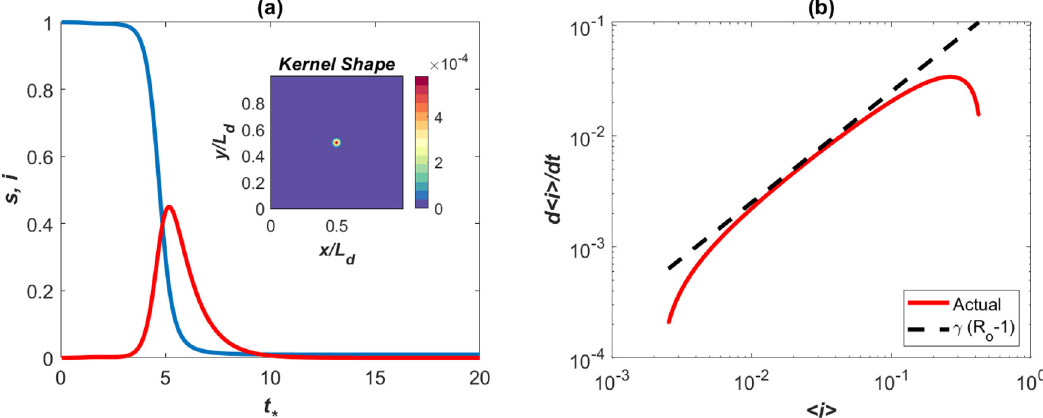
Fig 8. SIR model with super-spreaders: spatially integrated results. (a) Modeled < s ( t ) > and < i ( t ) > , where < . > is spatially integrated quantities (the inset shows the Gaussian spatial spread kernel). (b) The early times dynamics showing the effects of super- spreaders in the phase of d < i > / dt versus < i > . The line ( R those reported in the UK and Italy regions.